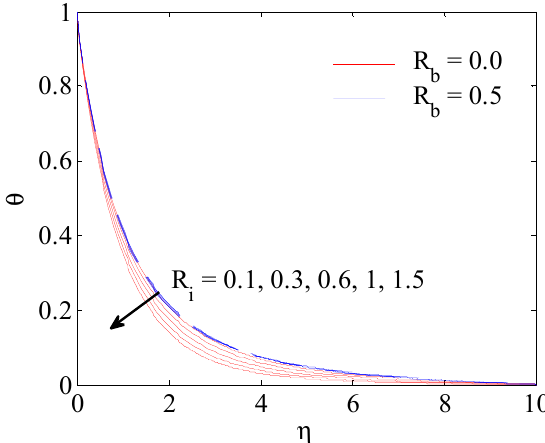
Figure 9. Fluctuations of θ due to the factor ε .